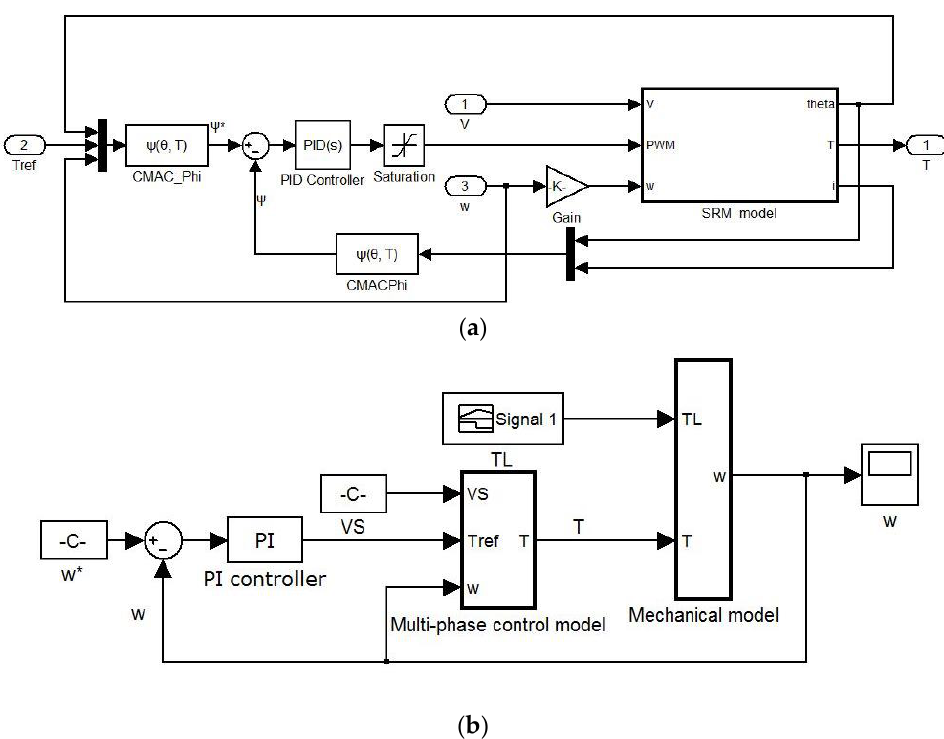
Figure 9. ( a ) Single phase simulation model ( b ) Overall simulation model of SRM.